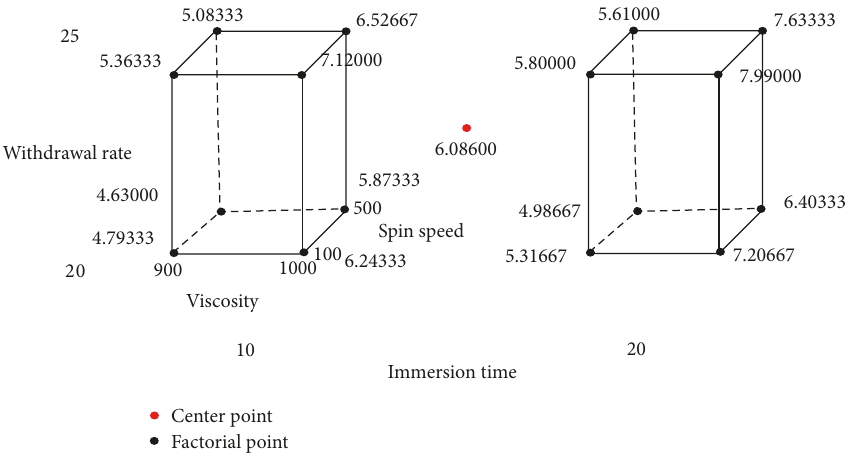
Figure 9: Cube plot for coating